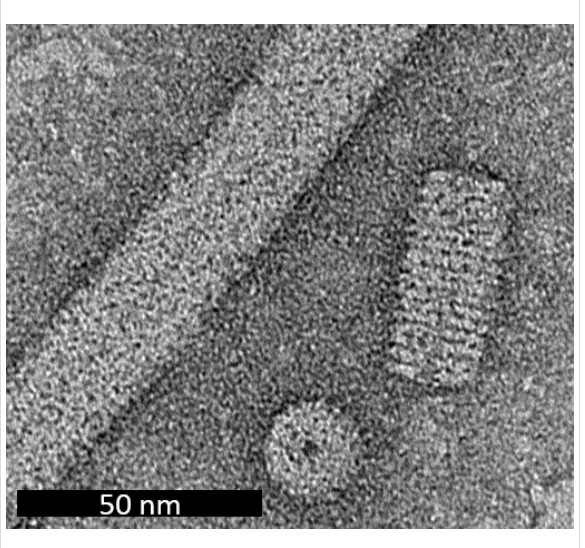
Figure 1: TEM image showing disk, stacked disk, and helical rod parti-